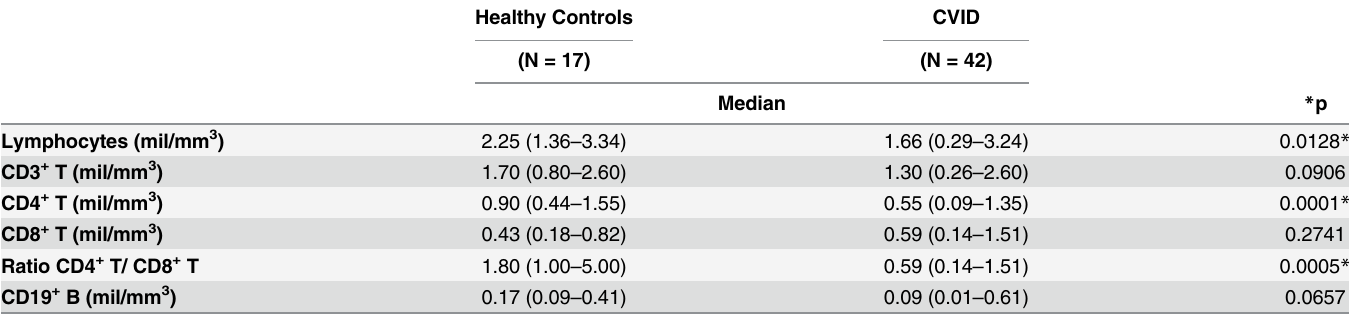
Table 2. Laboratory characteristics of CVID patients and healthy